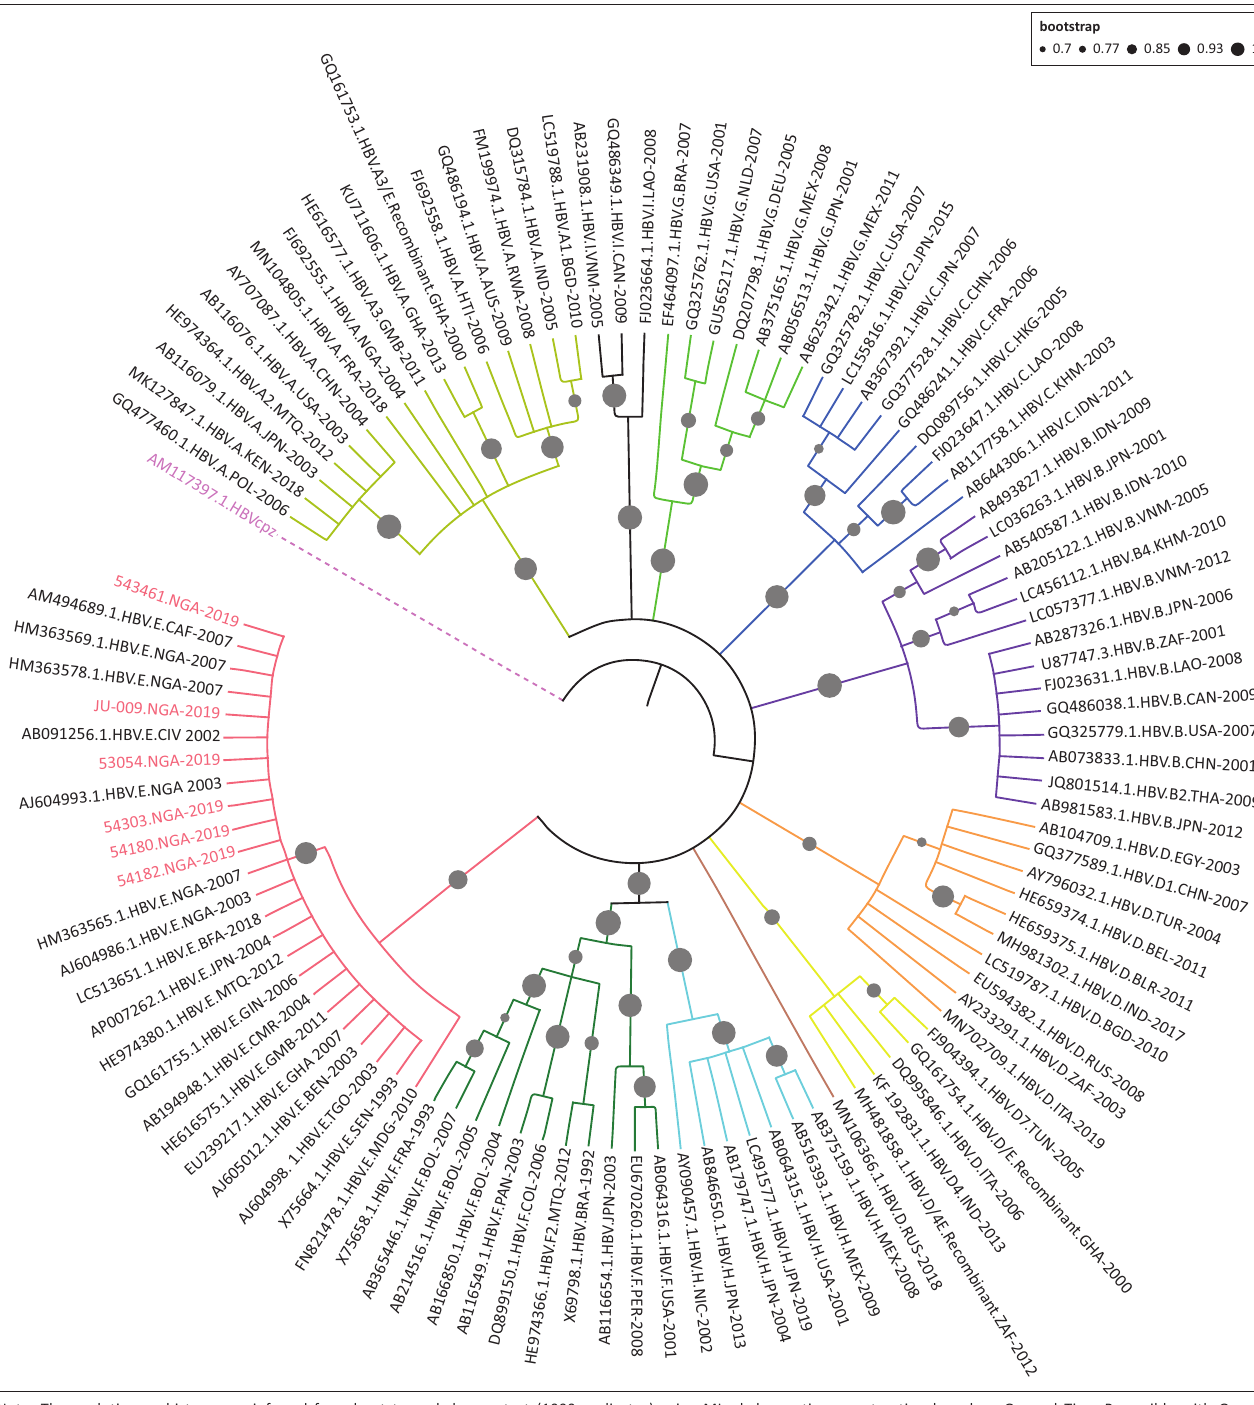
FIGURE 1: Phylogenetic maximum likelihood circular consensus tree with branch node statistics as viewed using interactive Tree of Life